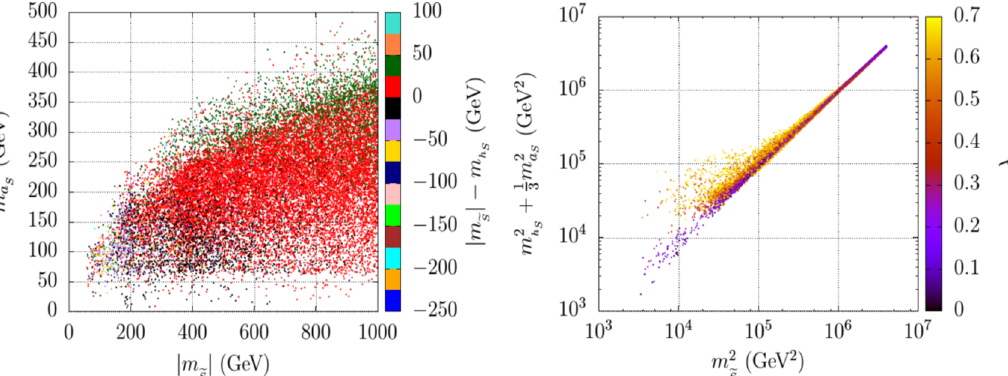
and m in the | m | , m a | – m a hS S S e S e S , ∆ (= | m ) being indicated via | and m | − m m ,m hS hS hS e S e S e S